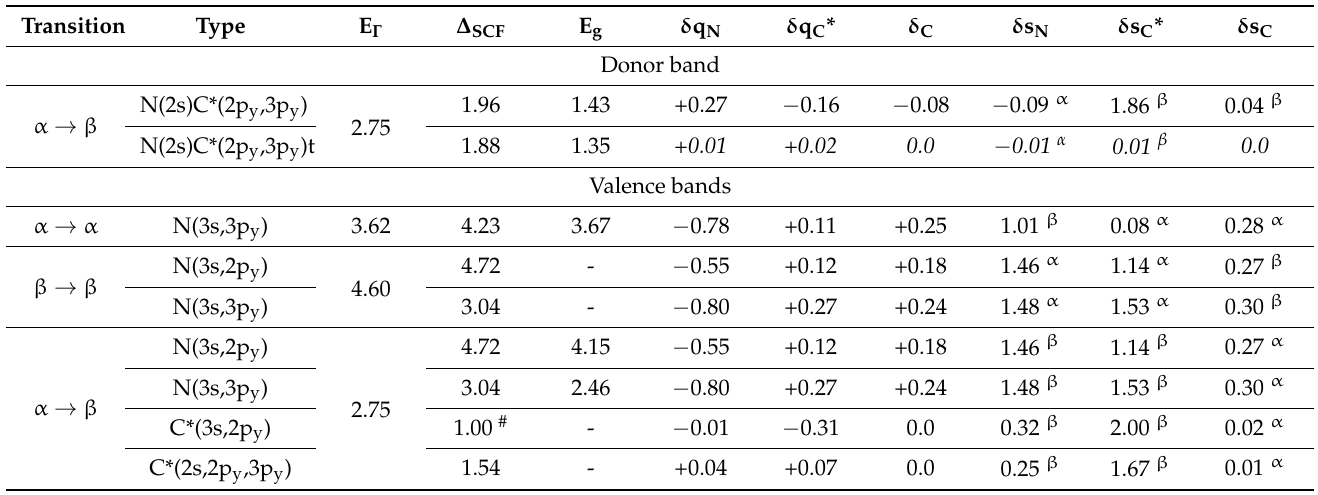
Table 5. N s0 B3LYP/6-21G Γ -point gap (E Γ ), direct SCF ( ∆ SCF ) and absorption edge (E g ) energies (eV) and changes to atomic charges ( | e | ), δ q N , δ q C* , δ q C , atomic spins ( | e | ), δ s N , δ s C* , δ s C , in N s0 . t denotes a thermally excited state. α and β refer to changes in spin-up and spin-down orbitals charges and spins, respectively.